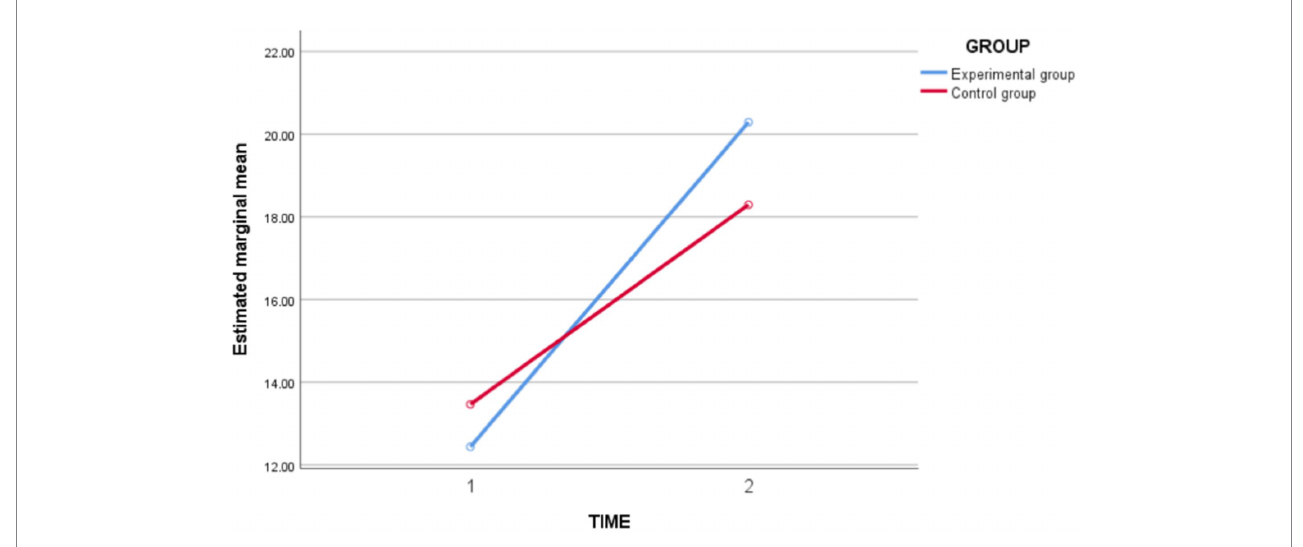
FIGURE 2 Schematic diagram of the changes in basketball skill level between the experimental and control groups before and after the intervention.